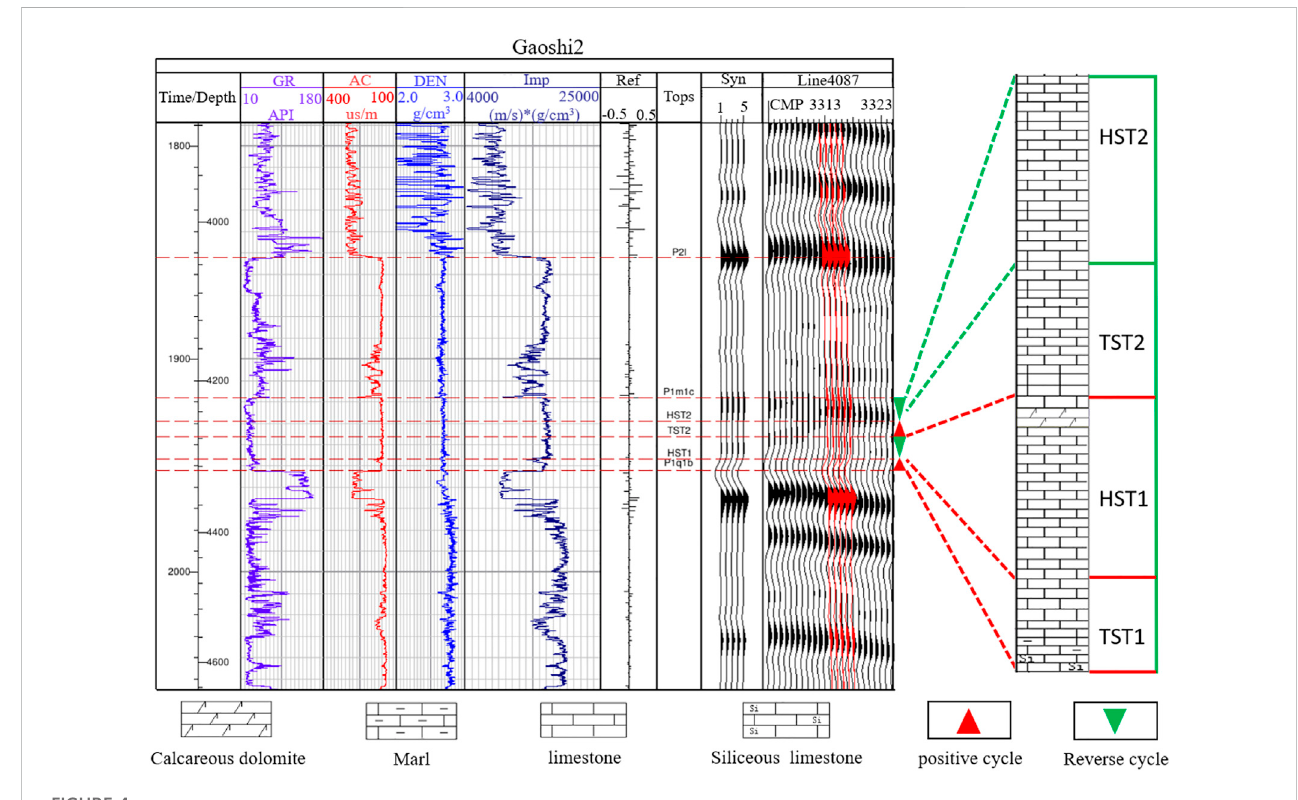
Seismic calibration pro fi le of the Gaoshi 2 well of the Qixia